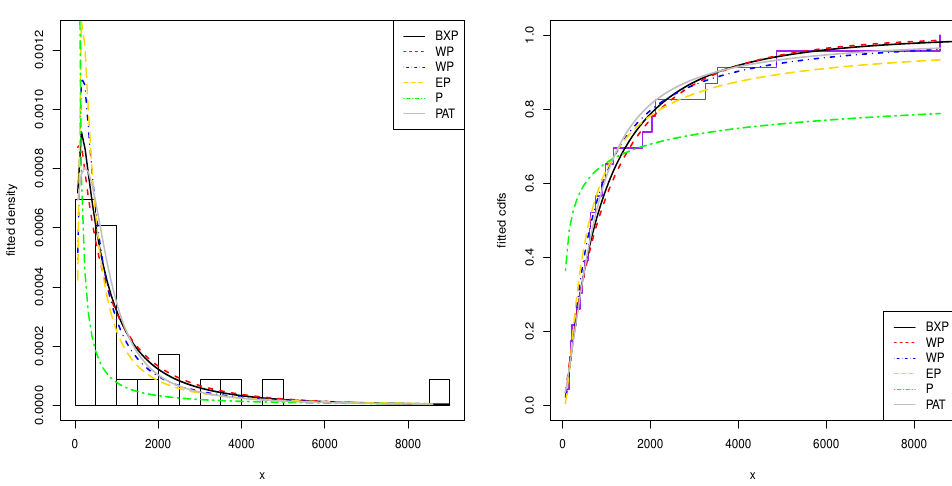
Figure 3. Fitted pdfs ( left panel ) and cdfs ( right panel ) of earthquake